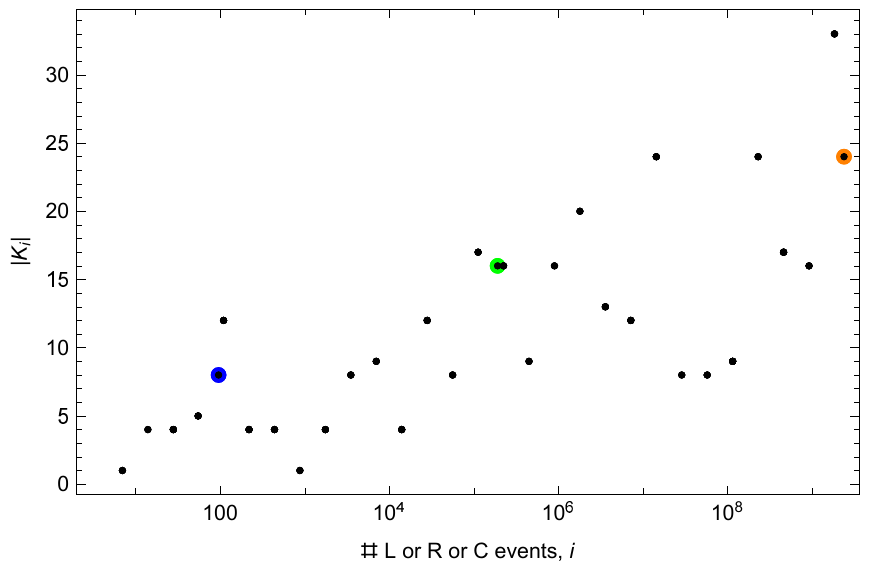
Figure 4: Counter K of [ 1 ] as a function of “time” i . In terms of [ 1 ] , the rest is the i same as in Fig.